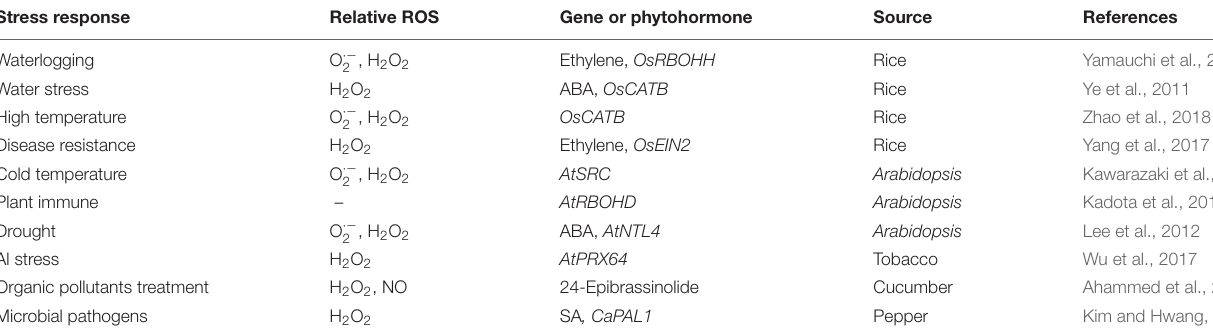
Some key genes involved in ROS homeostasis and their functions during plant stress response are listed in the table. “ − ” indicates that the specific types of ROS are not clearly specified in the literature. ABA, abscisic acid; SA, salicylic acid.